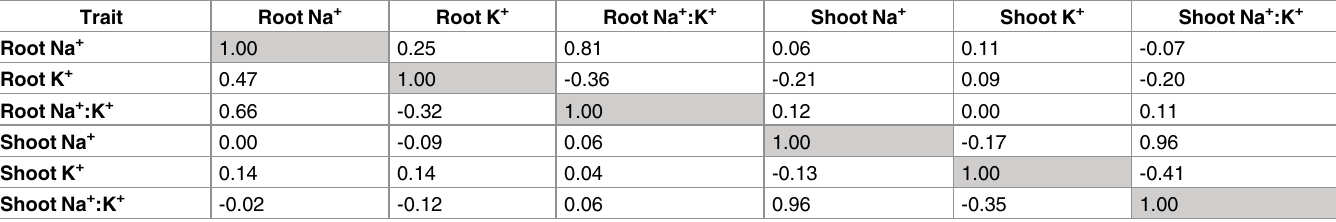
The lower diagonal represents the phenotypic Pearson correlation coefficients, while the upper diagonal represents the genetic correlation coefficients (n = 383). Here, the genetic correlation between traits accounts for population structure and relatedness between accessions of RDP1.